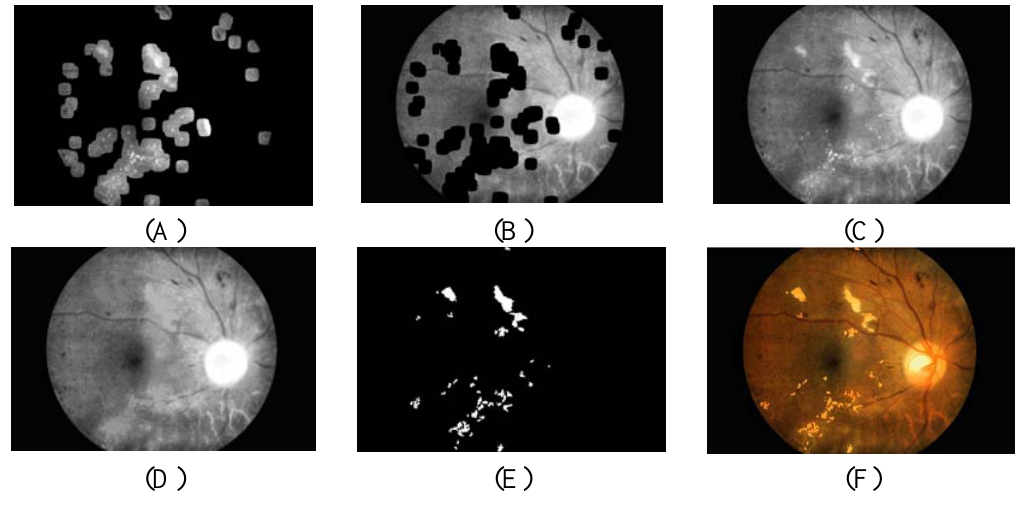
Figure 5. Exudates detection (A) Candidate areas after using FCM clustering. (B) Marker image. (C) Mask image. (D) Reconstructed image. (E) Difference image. (F) Result superimposed on the original